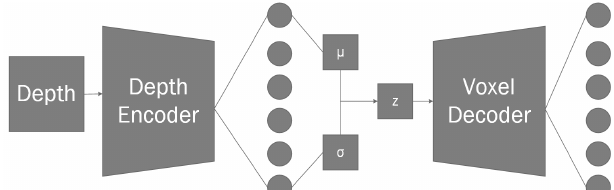
Figure 5. Diagram of a single object reconstruction network architecture branch. For the given depth frame, the depth encoder creates a bottleneck, which is then directly connected to VAE node, the resulting sampler is connected into voxel decoder. The voxel decoder layer outputs a 32 × 32 × 32 × 2 matrix which can be explained as x × y × z × s , where x, y, z components indicate position in 3D grid, and s component indicates voxel state encoded as one-hot. Table 2. Architecture of the reconstruction neural